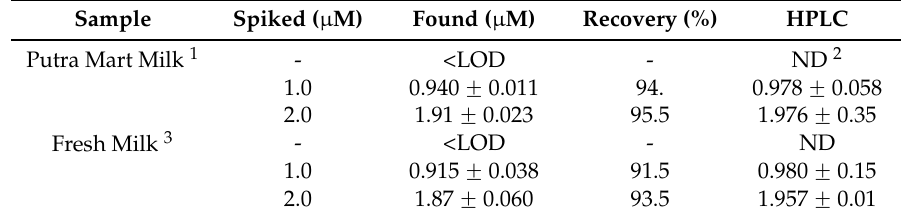
Determination of amoxicillin in some bovine milk samples using fabricated sensor. ( X ˘ SD , n “ 3 q . Sample Spiked ( µ M) Found ( µ M) Recovery (%) HPLC Putra Mart Milk 1 - <LOD - ND 2 1.0 0.940 ˘ 0.011